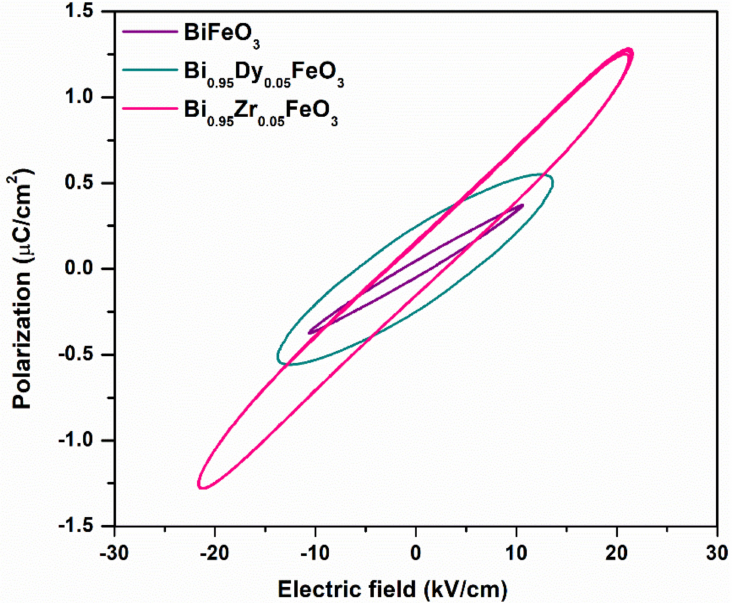
Figure 8. Room temperature P-E hysteresis loops for BFO, BDFO, and BZFO thin